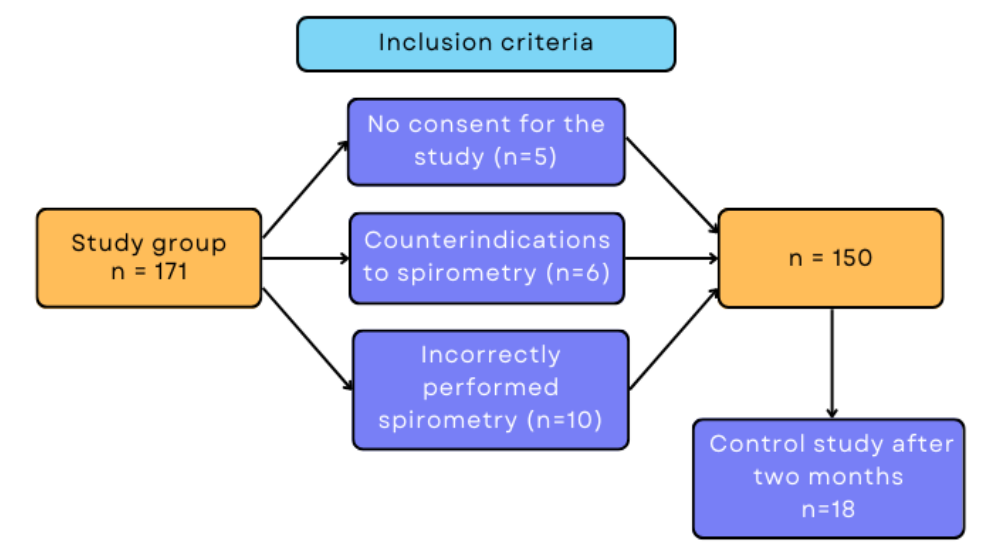
Figure 1. Flowchart of inclusion and exclusion criteria. Table 1. Rehabilitation